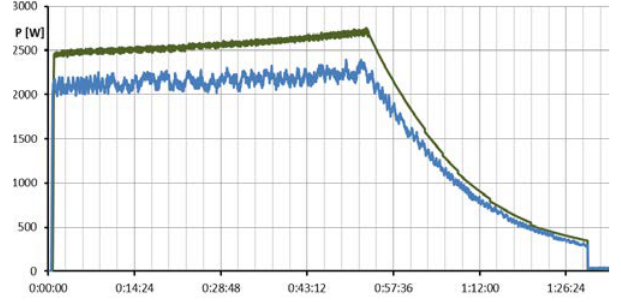
Fig. 10. Charging power of the battery (blue line) and electric power of the generator (green line) Theoretical efficiency of each vehicle’s module (from engine to wheel) should reach ca. 90%. Because of the quali- ty of components (the vehicle is technology demonstrator) efficiency of driving modules reaches 75% averages.